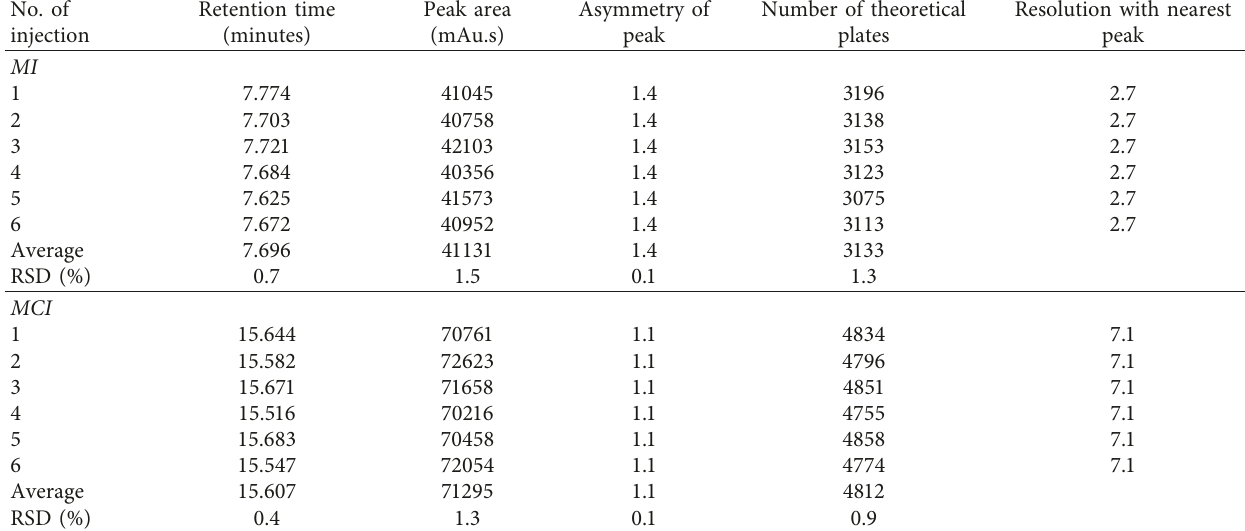
Table 5: Results of system precision.